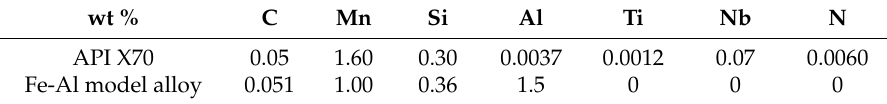
Table 1. Chemical composition of the new alloy used in this investigation (wt